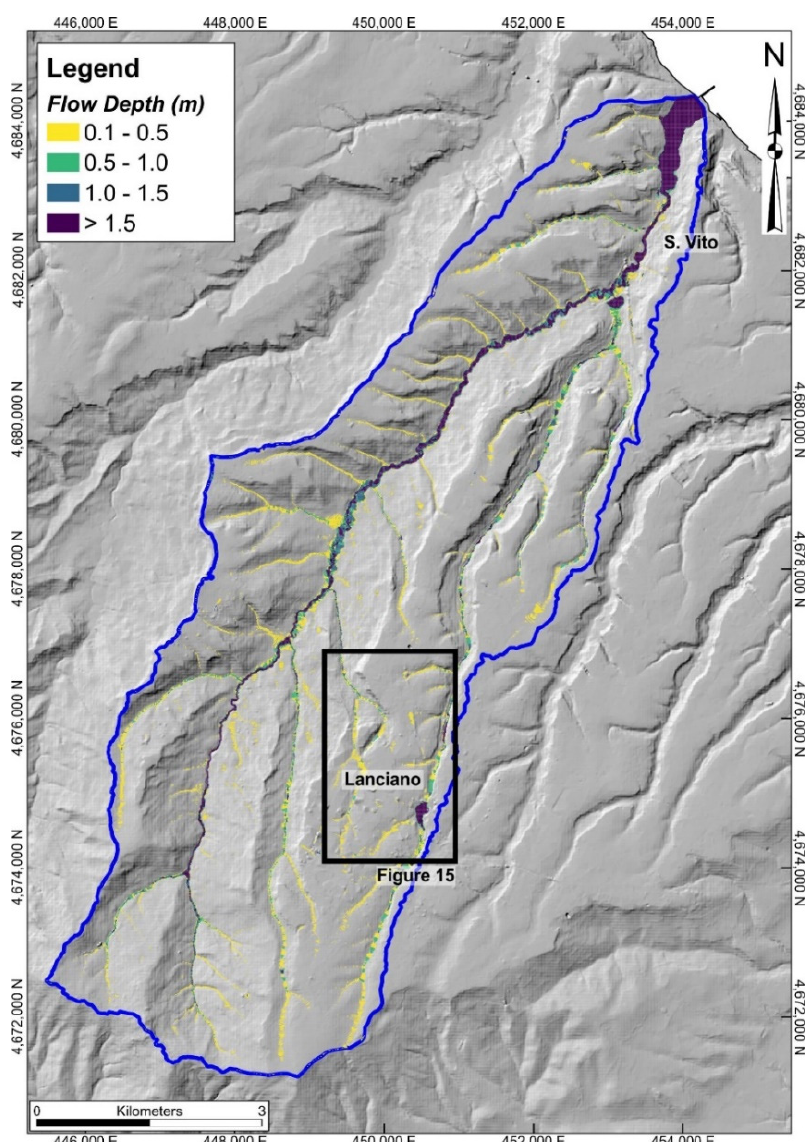
Figure 14. Results of the FLO-2D simulation, in terms of flow depth, in the Feltrino Stream basin, using the first rainfall distribution curve (Figure 13a). Blue line: Feltrino Stream basin.